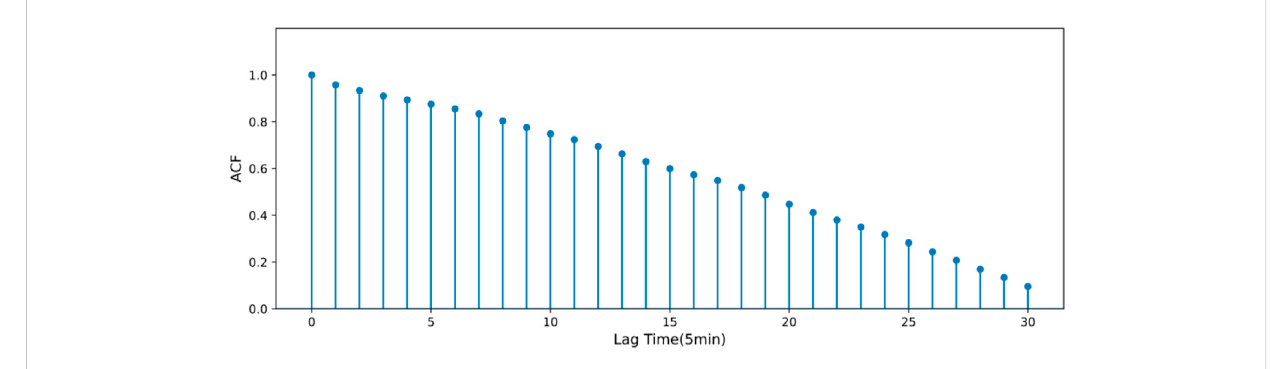
FIGURE 9 Autocorrelation analysis results of PV power based on ACF.